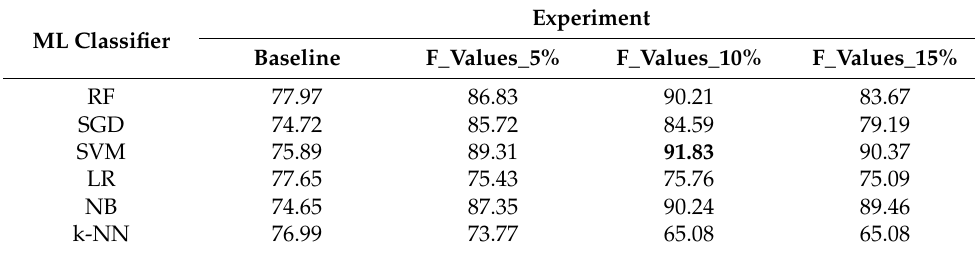
Table 10. Accuracy of different experiments with content-based features only.